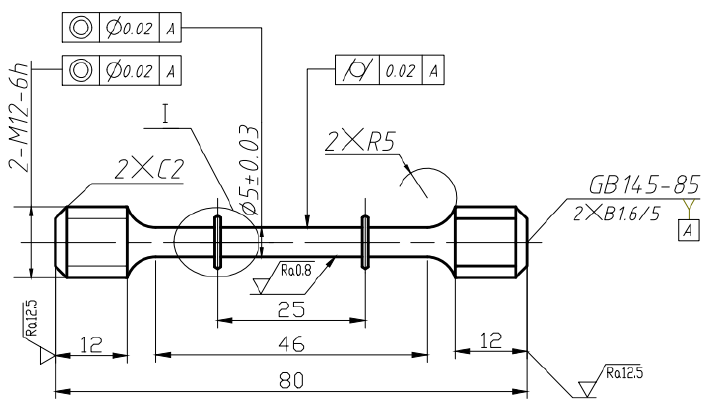
Figure 3. Schematic diagram of creep test sample size. Table 2. Different load levels for creep tests.